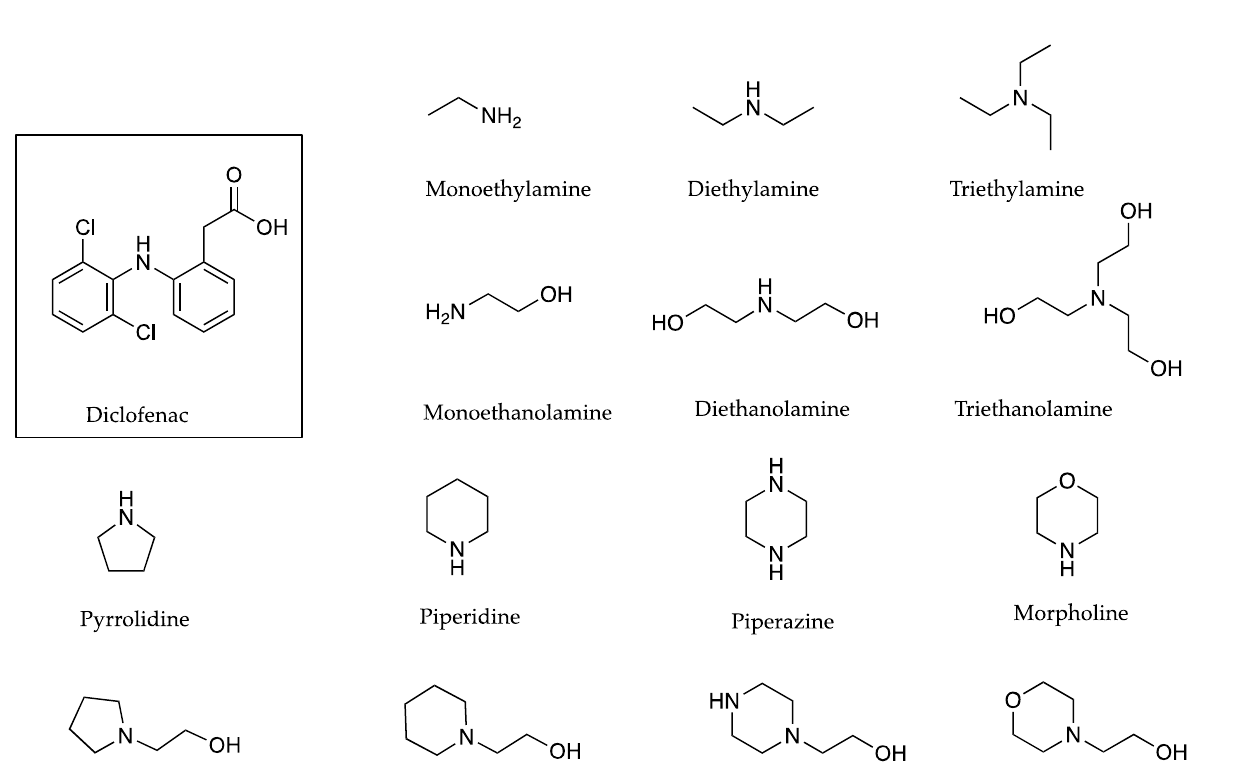
Figure 4. DIC with structurally related counter ions monoethylamine and monoethanolamine; diethylamine and diethanolamine; triethylamine and triethanolamine; pyrrolidine and N-(2-hydroxyethyl) pyrrolidine; piperidine and N-(2-hydroxyethyl) piperidine, piperazine and N-(2-hydroxyethyl) piperazine; and morpholine and N-(2-hydroxyethyl) morpholine.